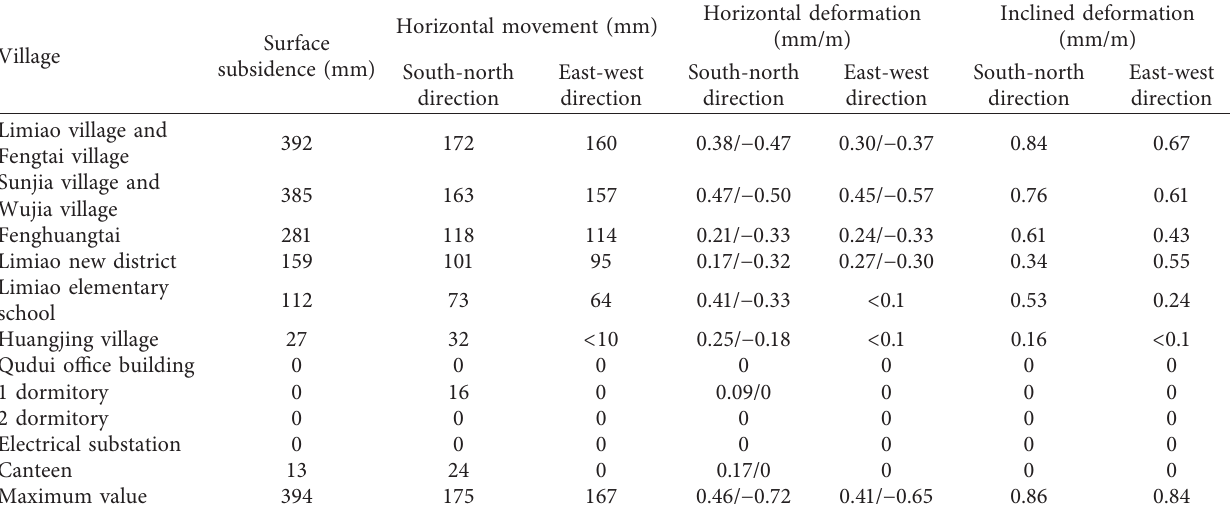
Figure 4: Relationship between mining depth, filling ratio, and Table 5: Maximum surface movement and maximum deformation.